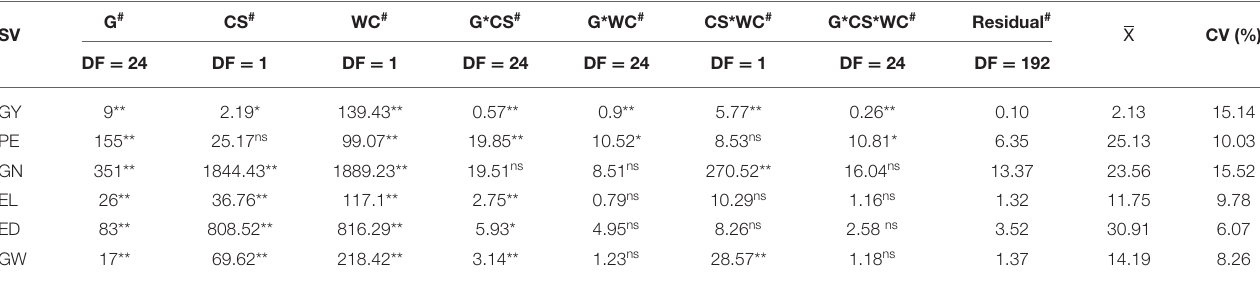
TABLE 3 | Summary of the analysis of variance, mean values, and coefficient of variation (CV) of agronomic traits evaluated in popcorn genotypes under different water conditions (WC) and crop seasons (CS). SV